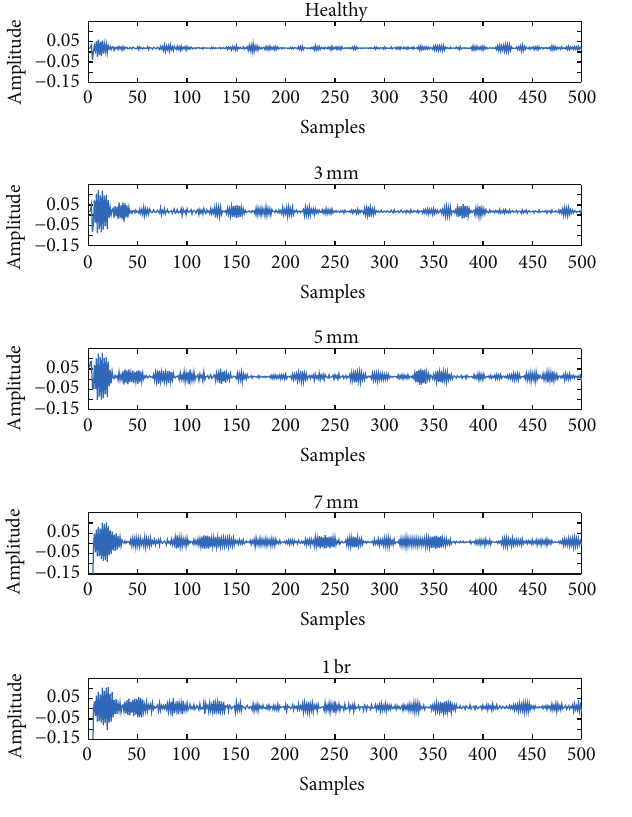
Figure 14: Approximation coefficients at full mechanical load, 𝐴 𝑥 - axis.